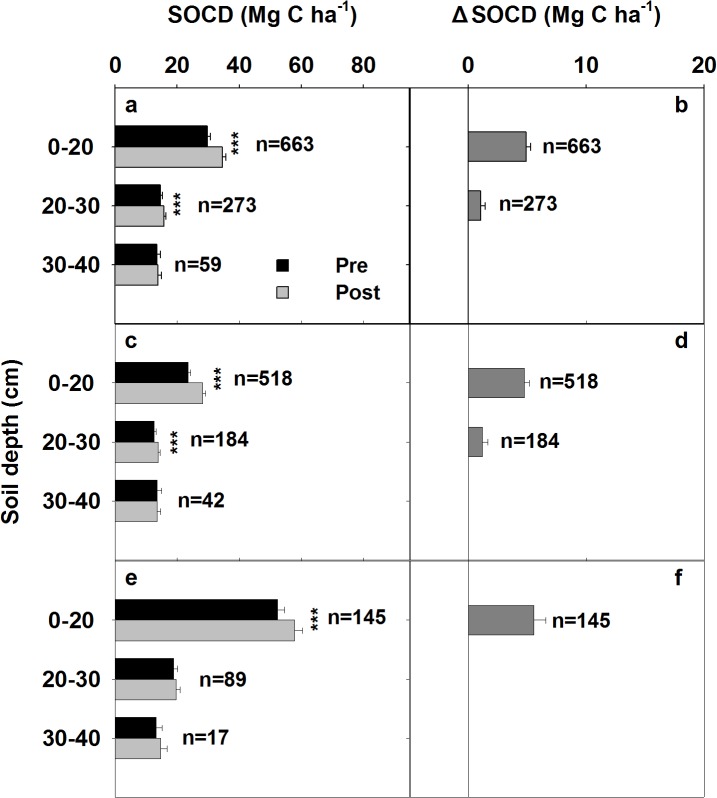
Profile of SOCD and ΔSOCD in 0‒40 cm soil layer: for all grasslands (a, b), temperate grasslands (c, d), and alpine grassland+mountain grassland (e, f).The error bar represents the standard error. **and * represent the significance of the t-test at the 0.01 and 0.05 levels, respectively.